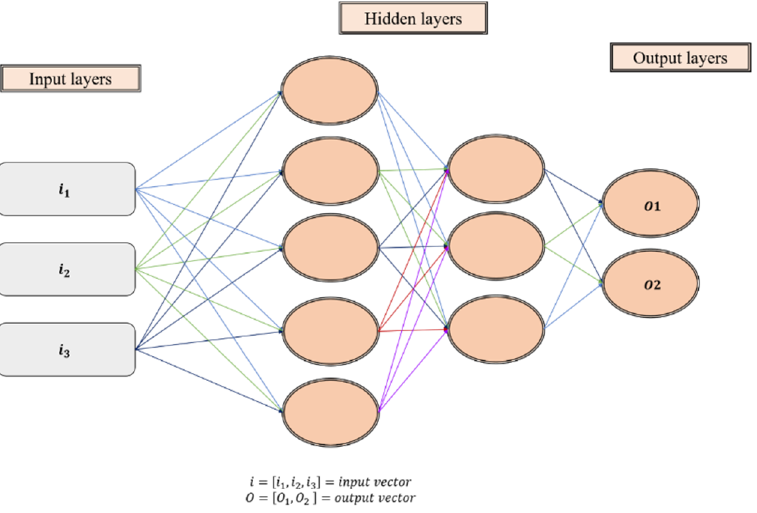
Figure 2. A two hidden layers multilayer perceptron.